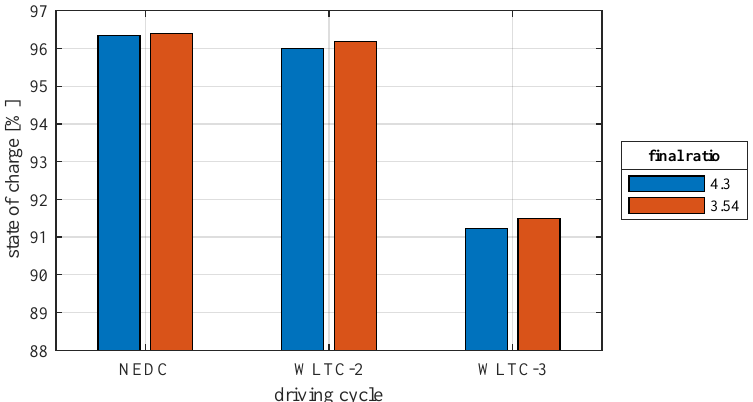
Figure 10. State of charge in driving cycles model results with final ratios 4.3 and